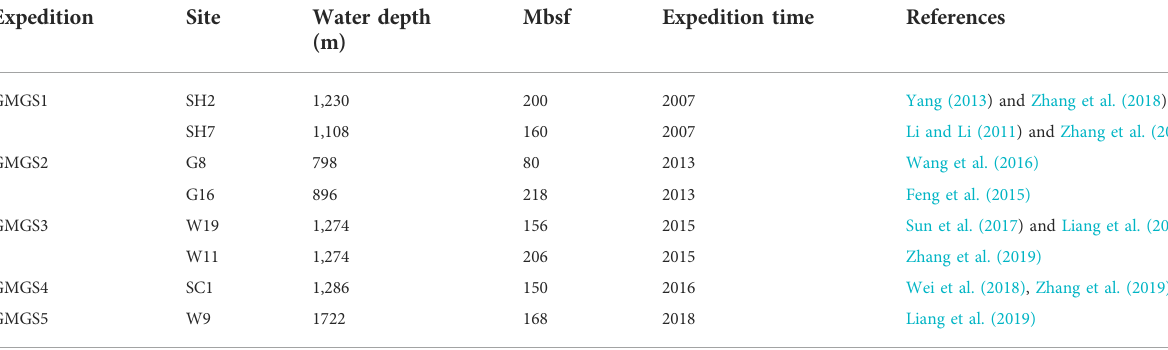
TABLE 3 Key parameters for hypothetical NGH